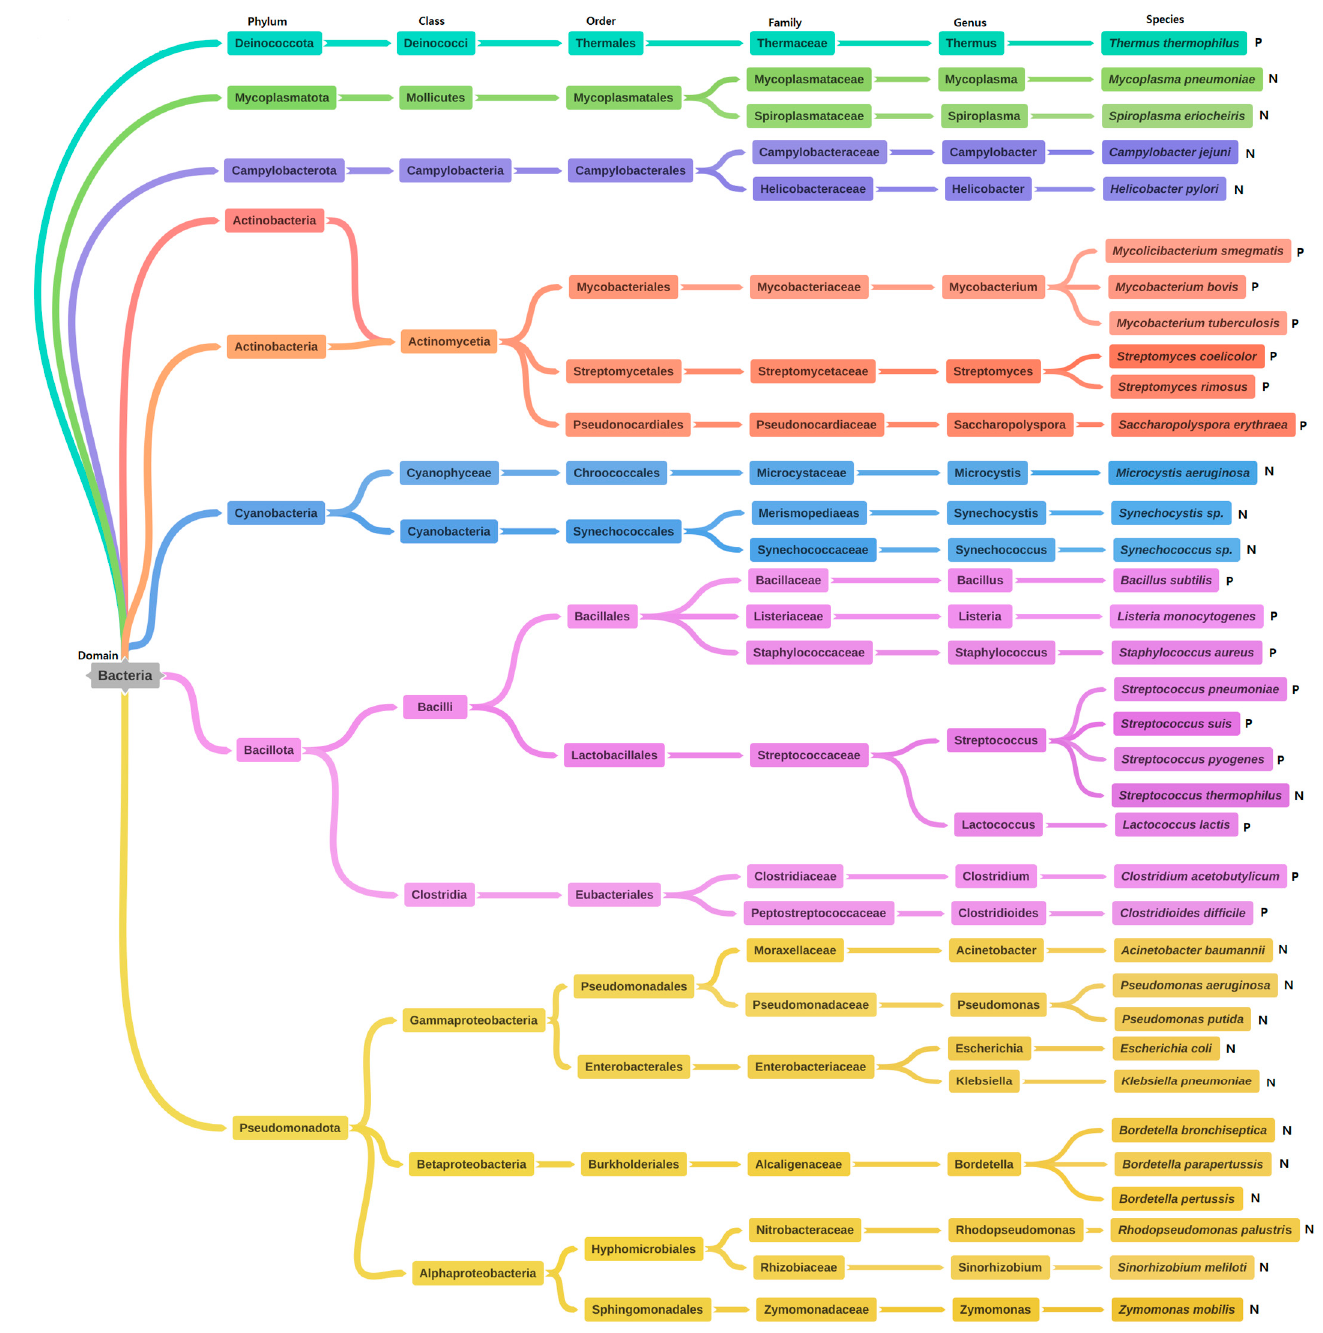
Figure 2. Taxonomic classi fi cations of bene fi cial microorganisms subjected to phosphorylation stud- ies. (P): Gram-positive bacteria and (N): Gram-negative